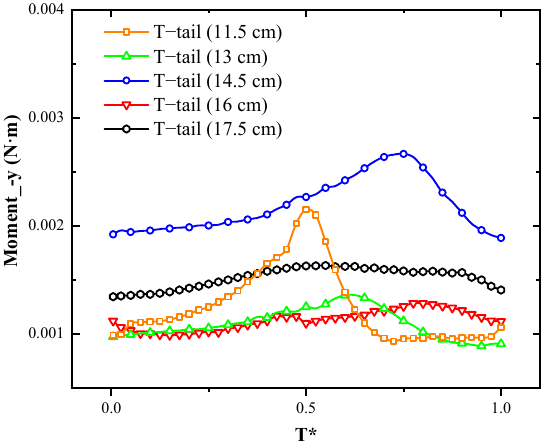
Figure 19. The momenty time history of inverted T-tail.